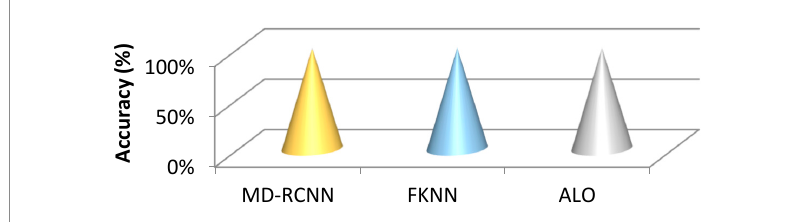
Table 2. Accuracy and precision analysis. Table 1. Analysis of False positive rate of different techniques.